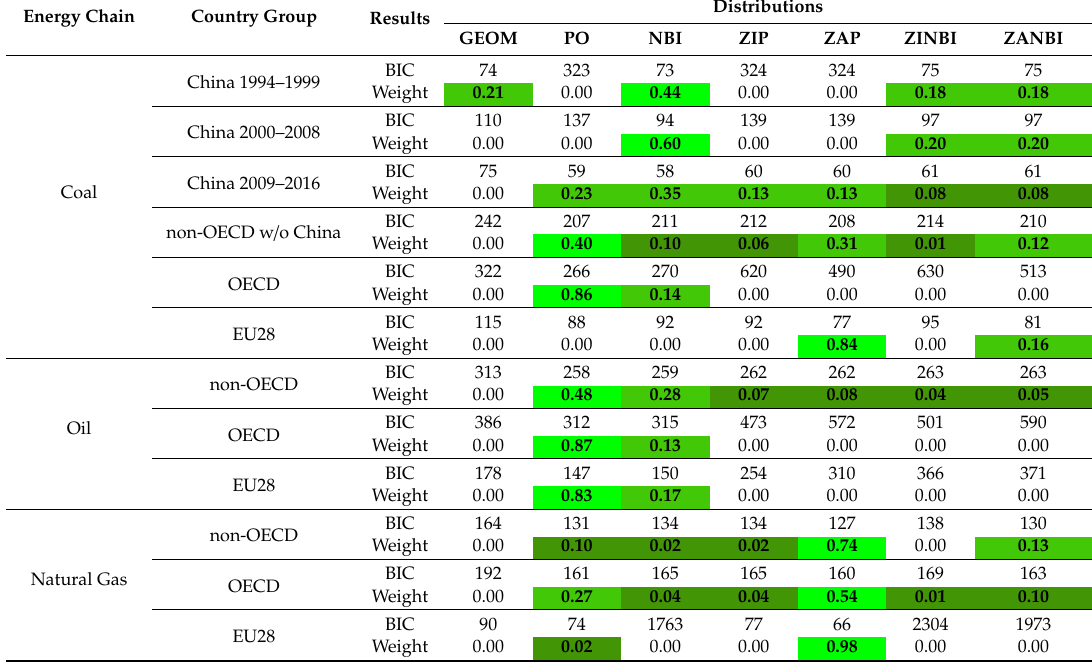
Table 3. Summary of goodness of fit (Bayesian Information Criterion (BIC) score) and relative posterior model weight (Weight) for the frequency distributions collected for di ff erent fossil energy chains and country groups. In bold the weights of each model contributing equal or more than 0.01%, and thus selected for further analysis. The green cells highlighted the di ff erent contribution of each model (the lighter the higher). GEOM = Geometric; PO = Poisson; NBI = Negative Binomial; ZIP = Zero-Inflated Poisson; ZAP = Zero-Altered Poisson; ZINBI = Zero-Inflated Negative Binomial; ZANBI = Zero-Altered Negative Binomial. Country Group Results